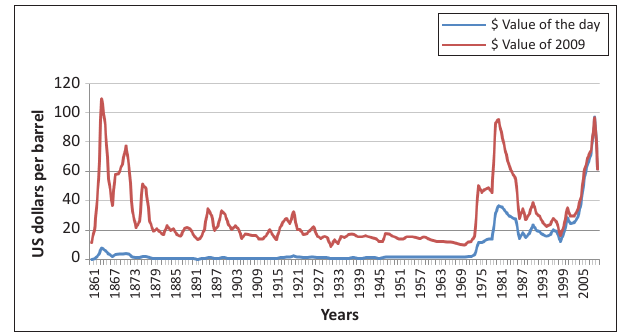
FIGURE 4: USA crude oil